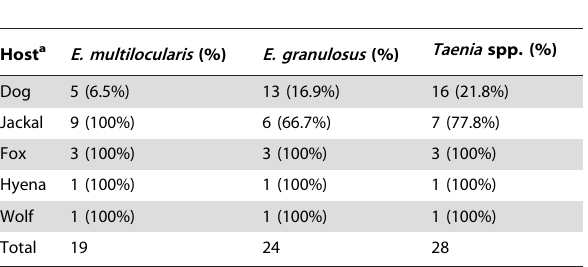
Table 1. Prevalence of E. multilocularis , E. granulosus , and Taenia spp. infection in fecal samples of canids.